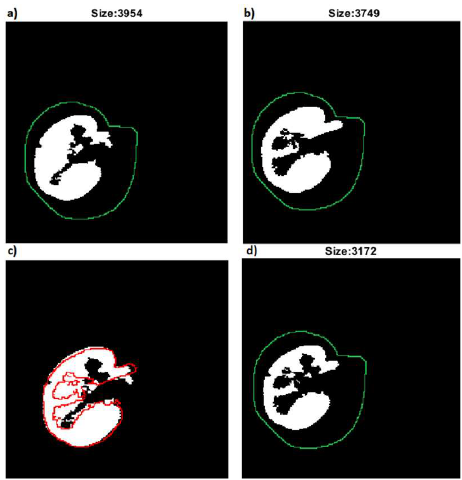
Figure 4. Example ( a ) Kidney mask of the 𝐶𝑡 𝑖 , ( b ) kidney mask of the 𝐶𝑡 𝑖+1 , ( c ) overlay of both masks ( d ) Result of the 𝑏𝑖𝑡𝑎𝑛𝑑 operation. An exemplary search starting search area ( 𝑆𝑚 ) is marked in green.